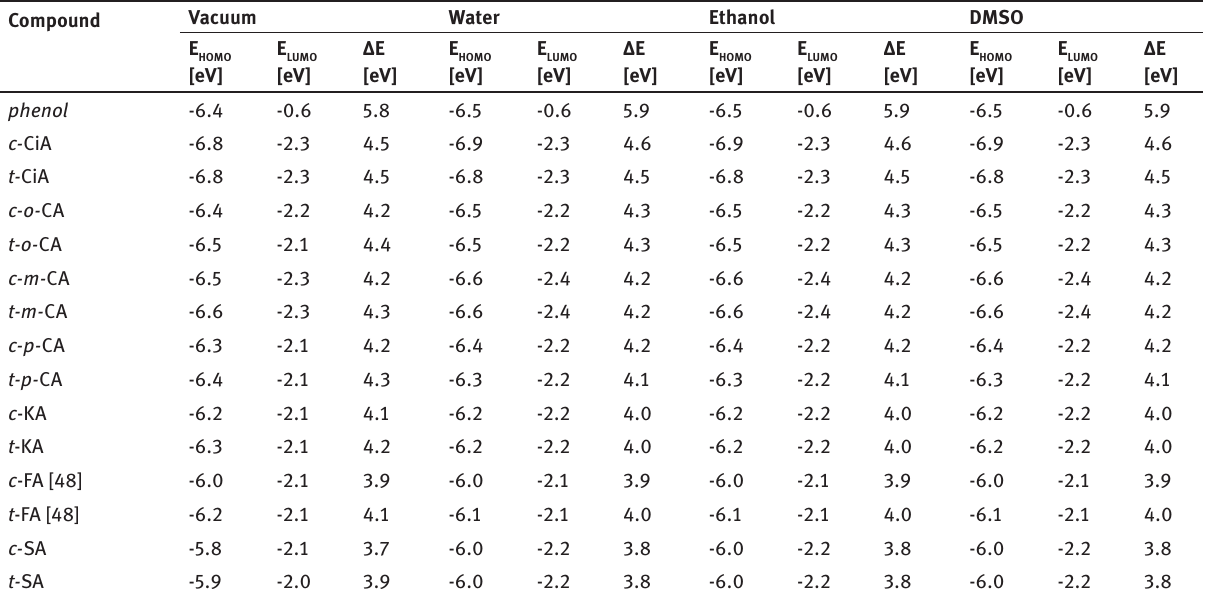
, E and ∆E(E – E ) calculated with B3LYP/6-311++G(2d,2p) in vacuum, water, ethanol and DMSO. Table 8: E HOMO LUMO LUMO HOMO Compound Vacuum Water Ethanol DMSO